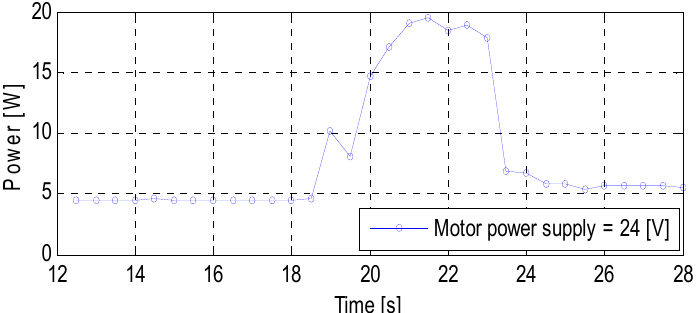
Figure 4. Power consumption during drillability test performed for white foamglas S sample using